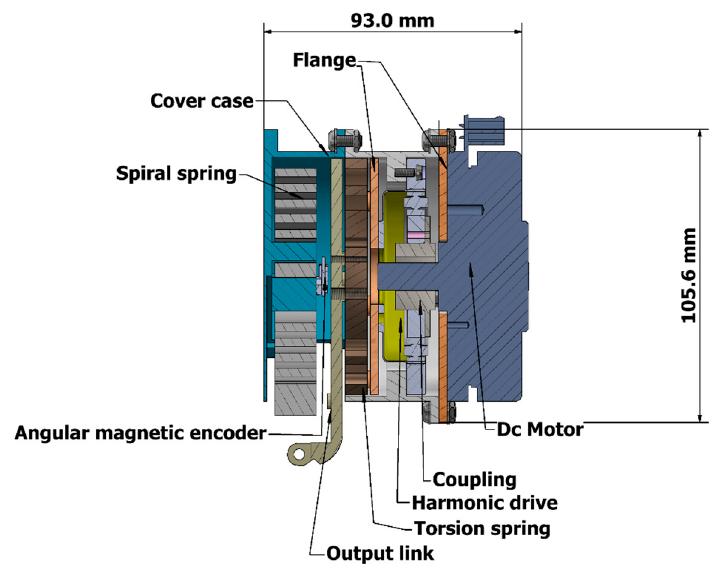
Figure 7. Cross ‐ section of ES ‐ RSEA .